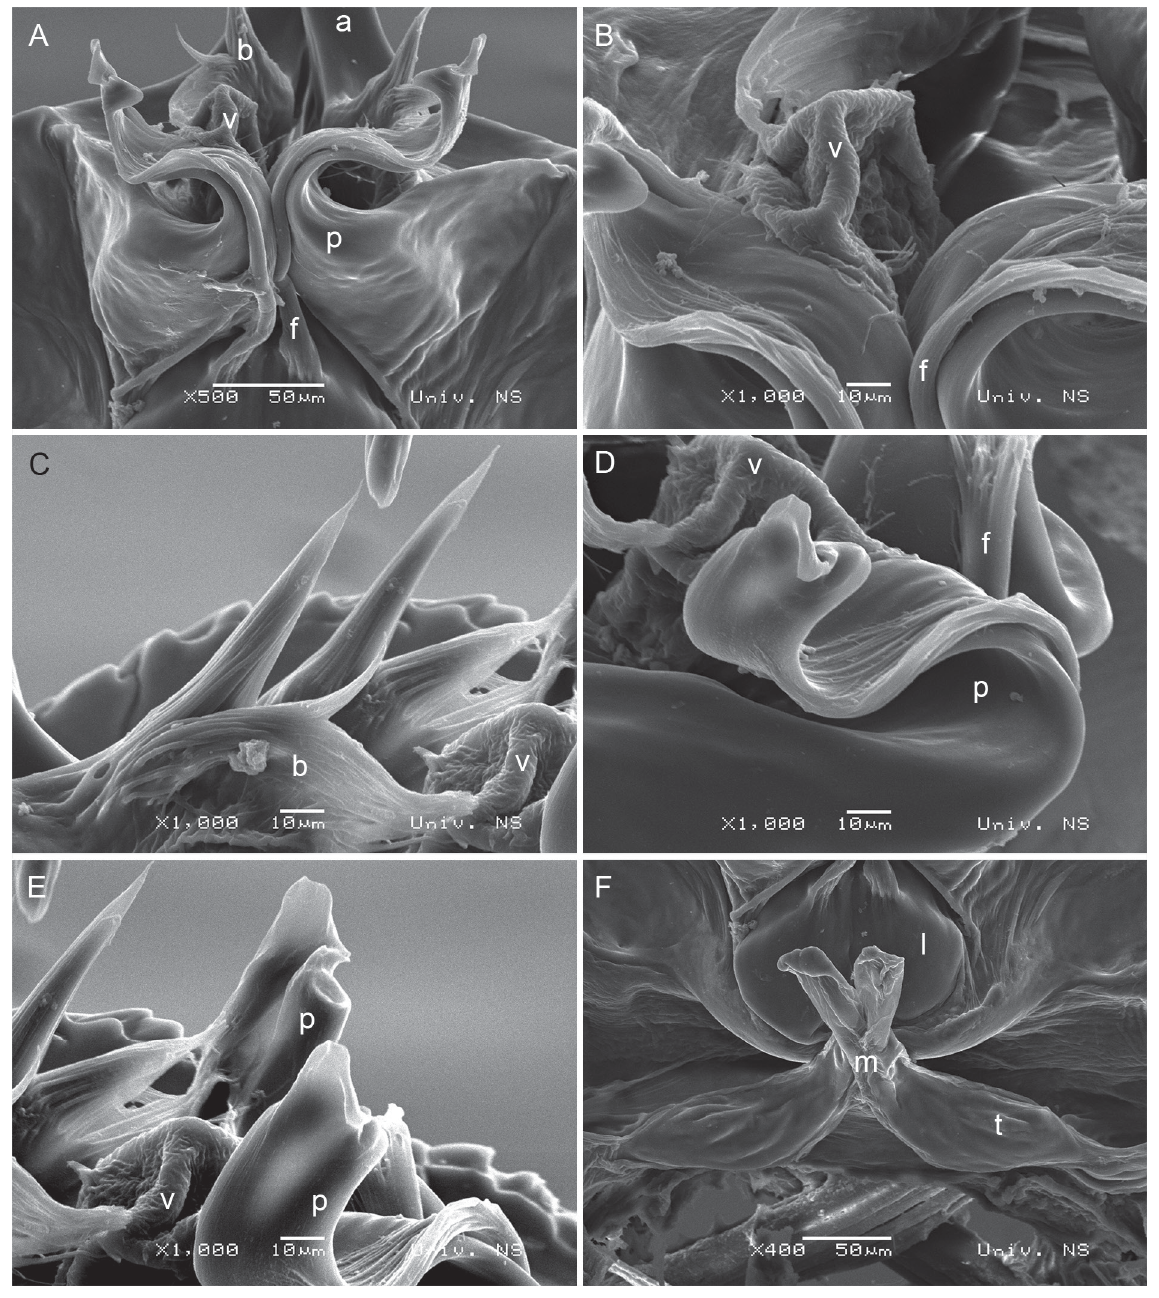
Fig. 6. Biokoviella mosorensis Antić & Dražina sp. nov., ♂, paratype, gonopods. A . Anterior gonopods, posterior view. B . Anterior gonopods, postero-distal view of vesicle. C . Anterior gonopods, lateral view of bristle apparatus. D . Anterior gonopods, latero-distal view of posterior coxal process and vesicle. E . Anterior gonopods, lateral view of the apex of posterior coxal processes. F . Posterior gonopods, postero-distal view. Abbreviations: see Material